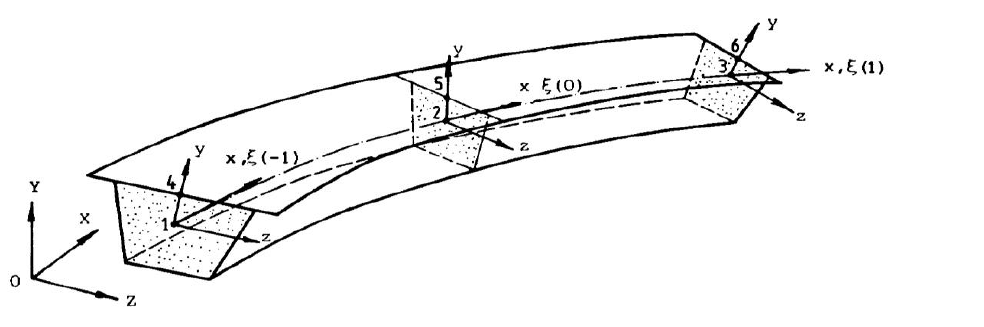
Fig. 1. Three noded thin-walled box beam